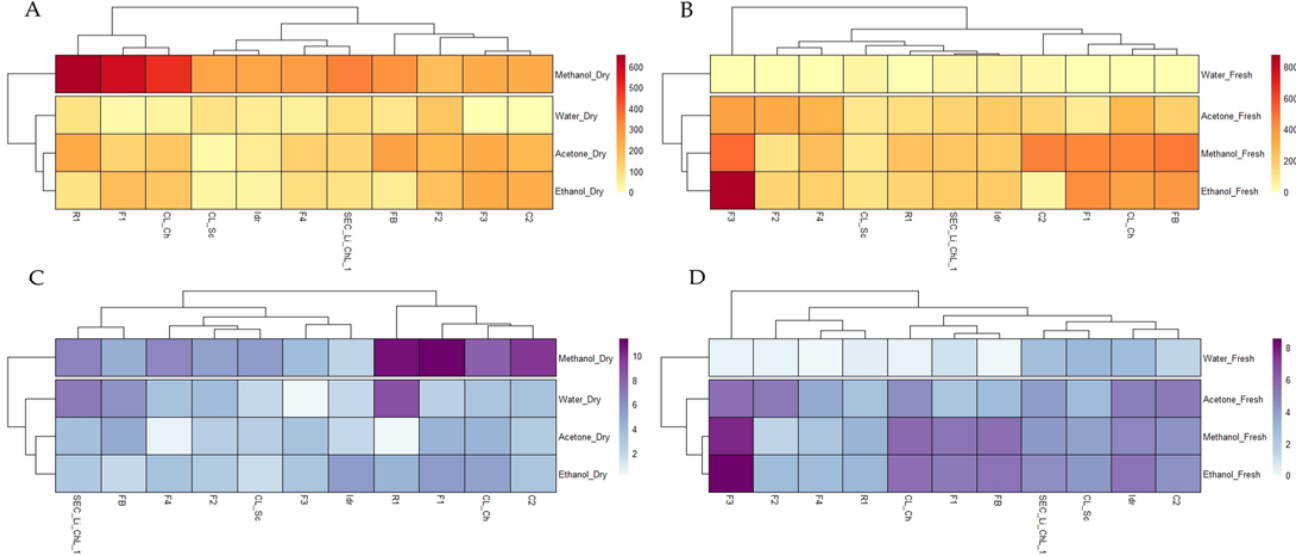
Figure 2. Heatmaps representing FRAP results of the dry ( A ) and fresh ( B ) biomass and DPPH results of the dry ( C ) and fresh ( D ) biomass of the microalgal strains under different types of solvent extraction. Each datum was obtained from the averaged values of three replicate measures.